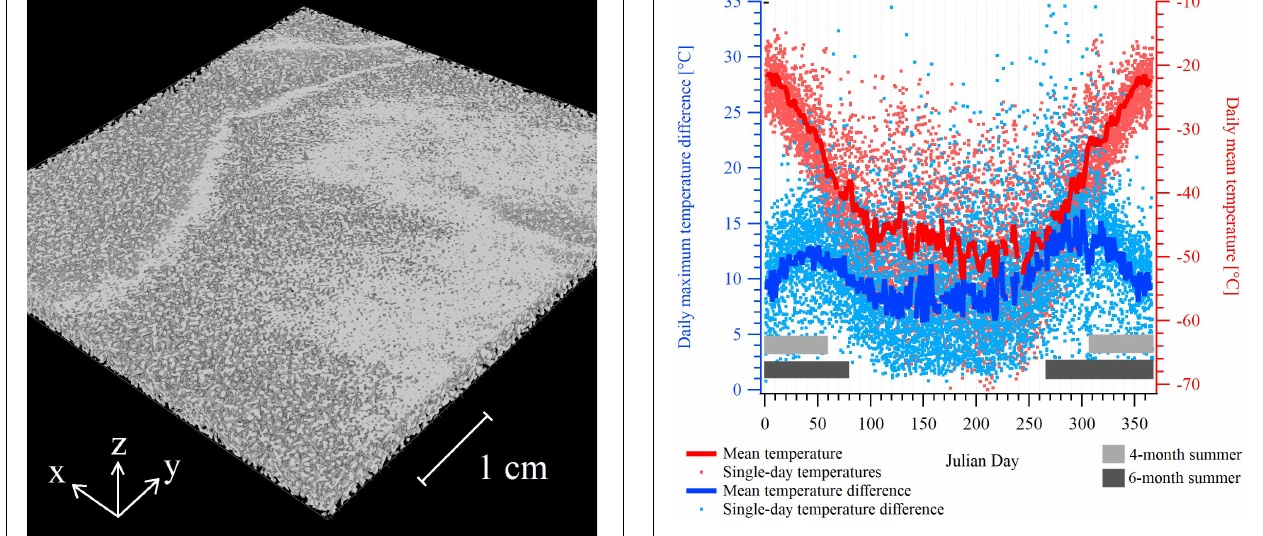
FIGURE 3 | 3D section of a crust at ∼ 0.26 m depth; color code: white = ice, black = air.